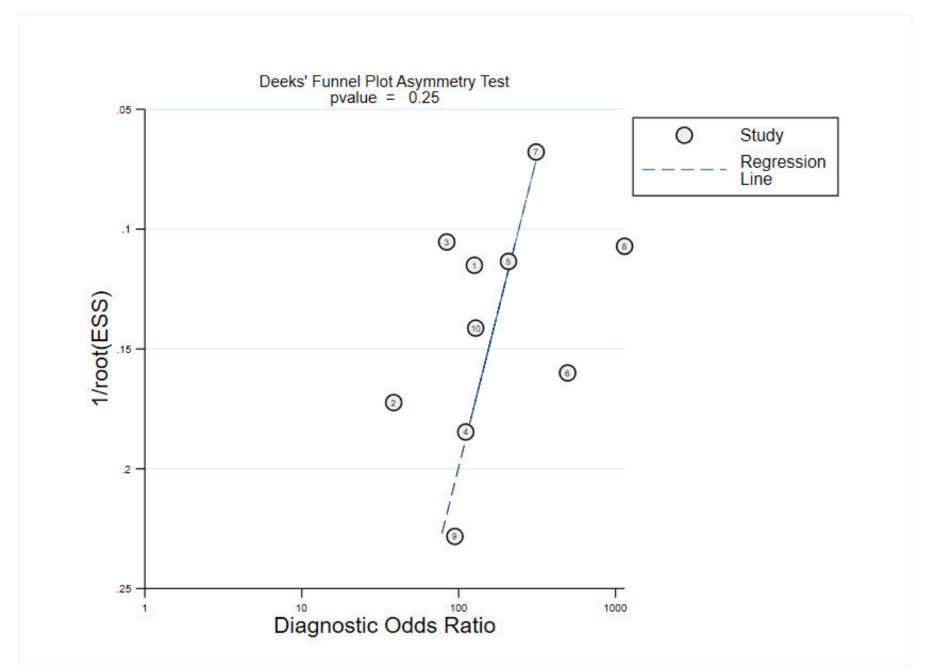
Figure 5. Deeks’ funnel plot for assessment of publication bias.